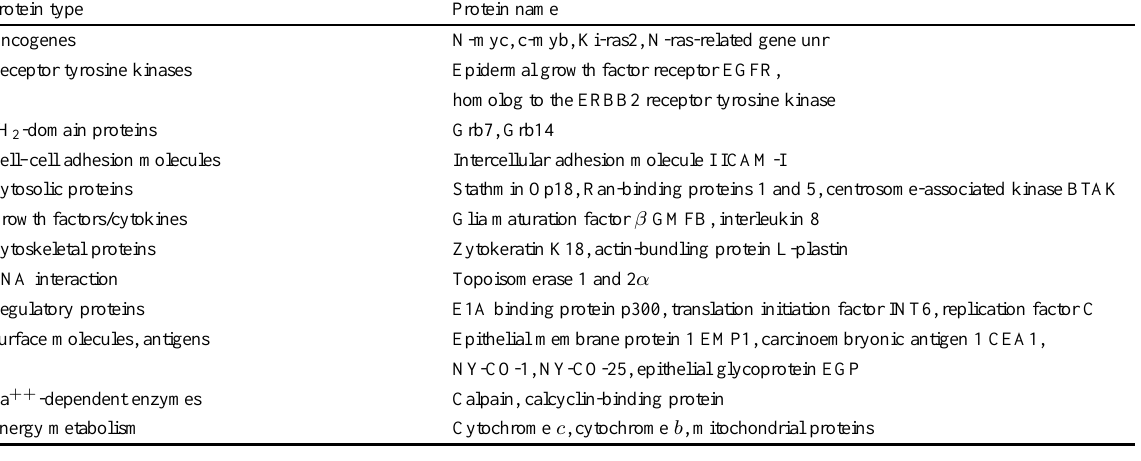
Overexpressed genes identified by